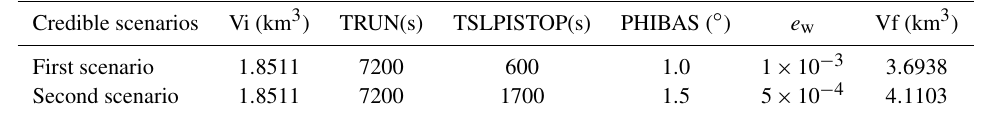
Table 1. Table of key parameters used for produced the two most credible scenarios. Vi is initial volume, TRUN is total simulated time, the slide stops its displacement at TSLISTOP seconds after being triggered, PHIBAS is basal friction angle, e w is water entrainment coefficient and Vf is final volume of the slide.